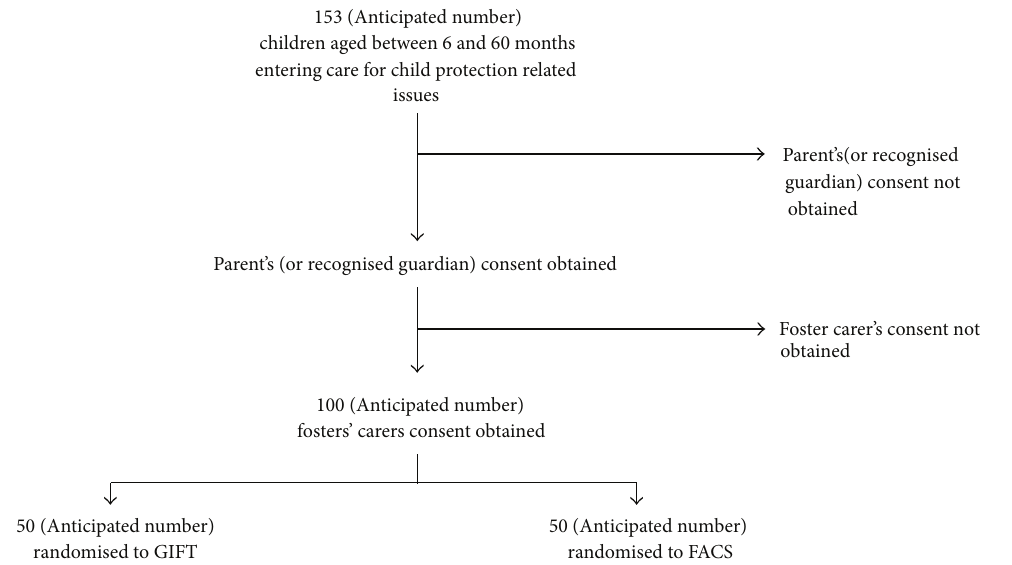
Figure 1: Anticipated number of eligible children recruited and randomised in the trial between December 2011 and April